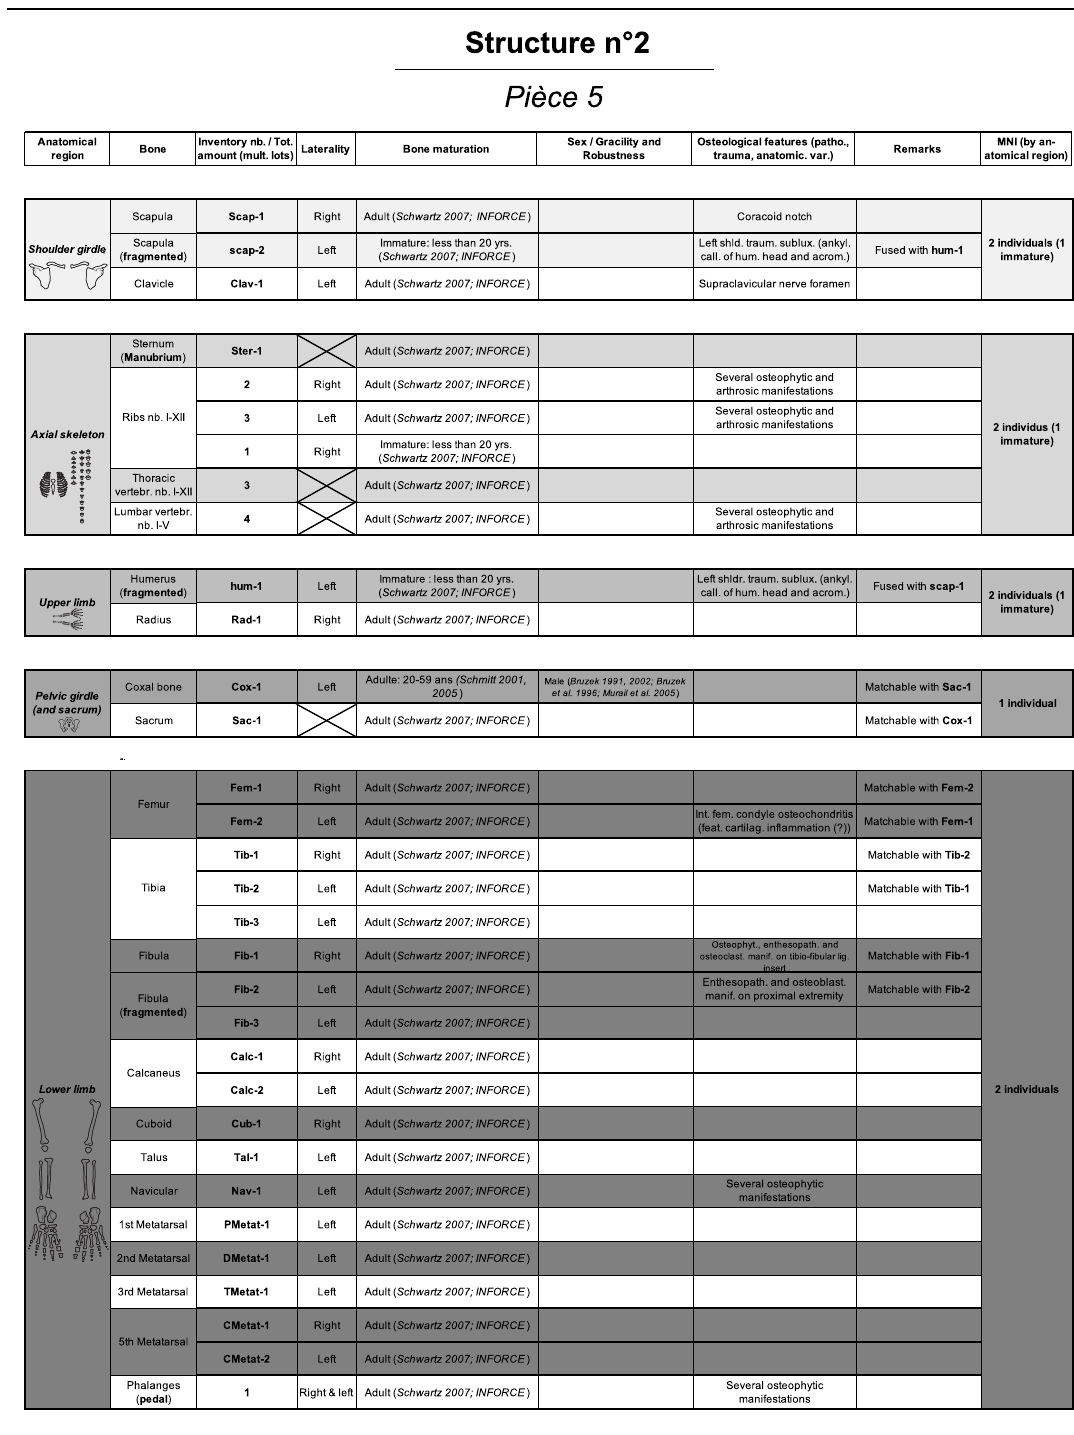
Figure by Hofstetter ( 2017 )